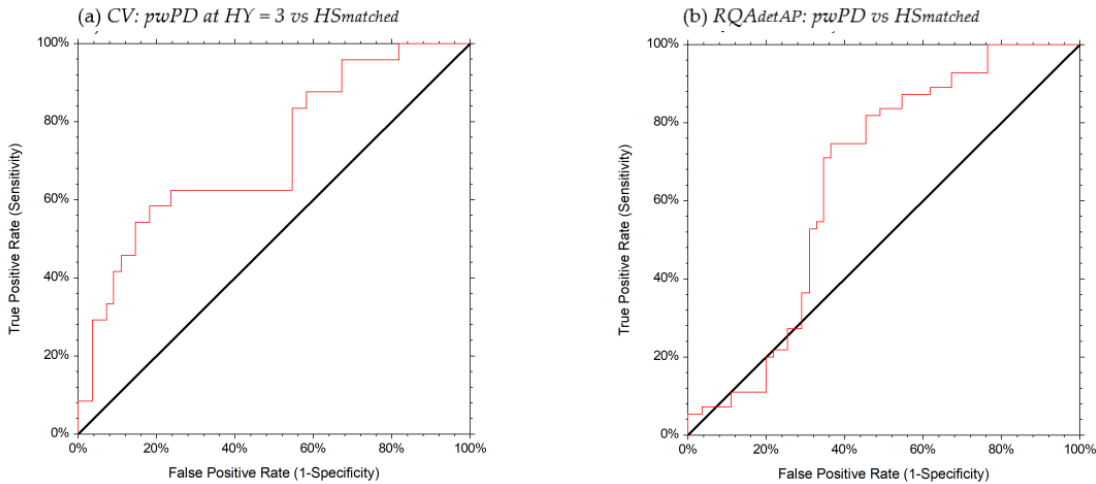
Figure 4. ROC curves of the CV ( a ) and RQAdetAP ( b ) in discriminating pwPD from HS